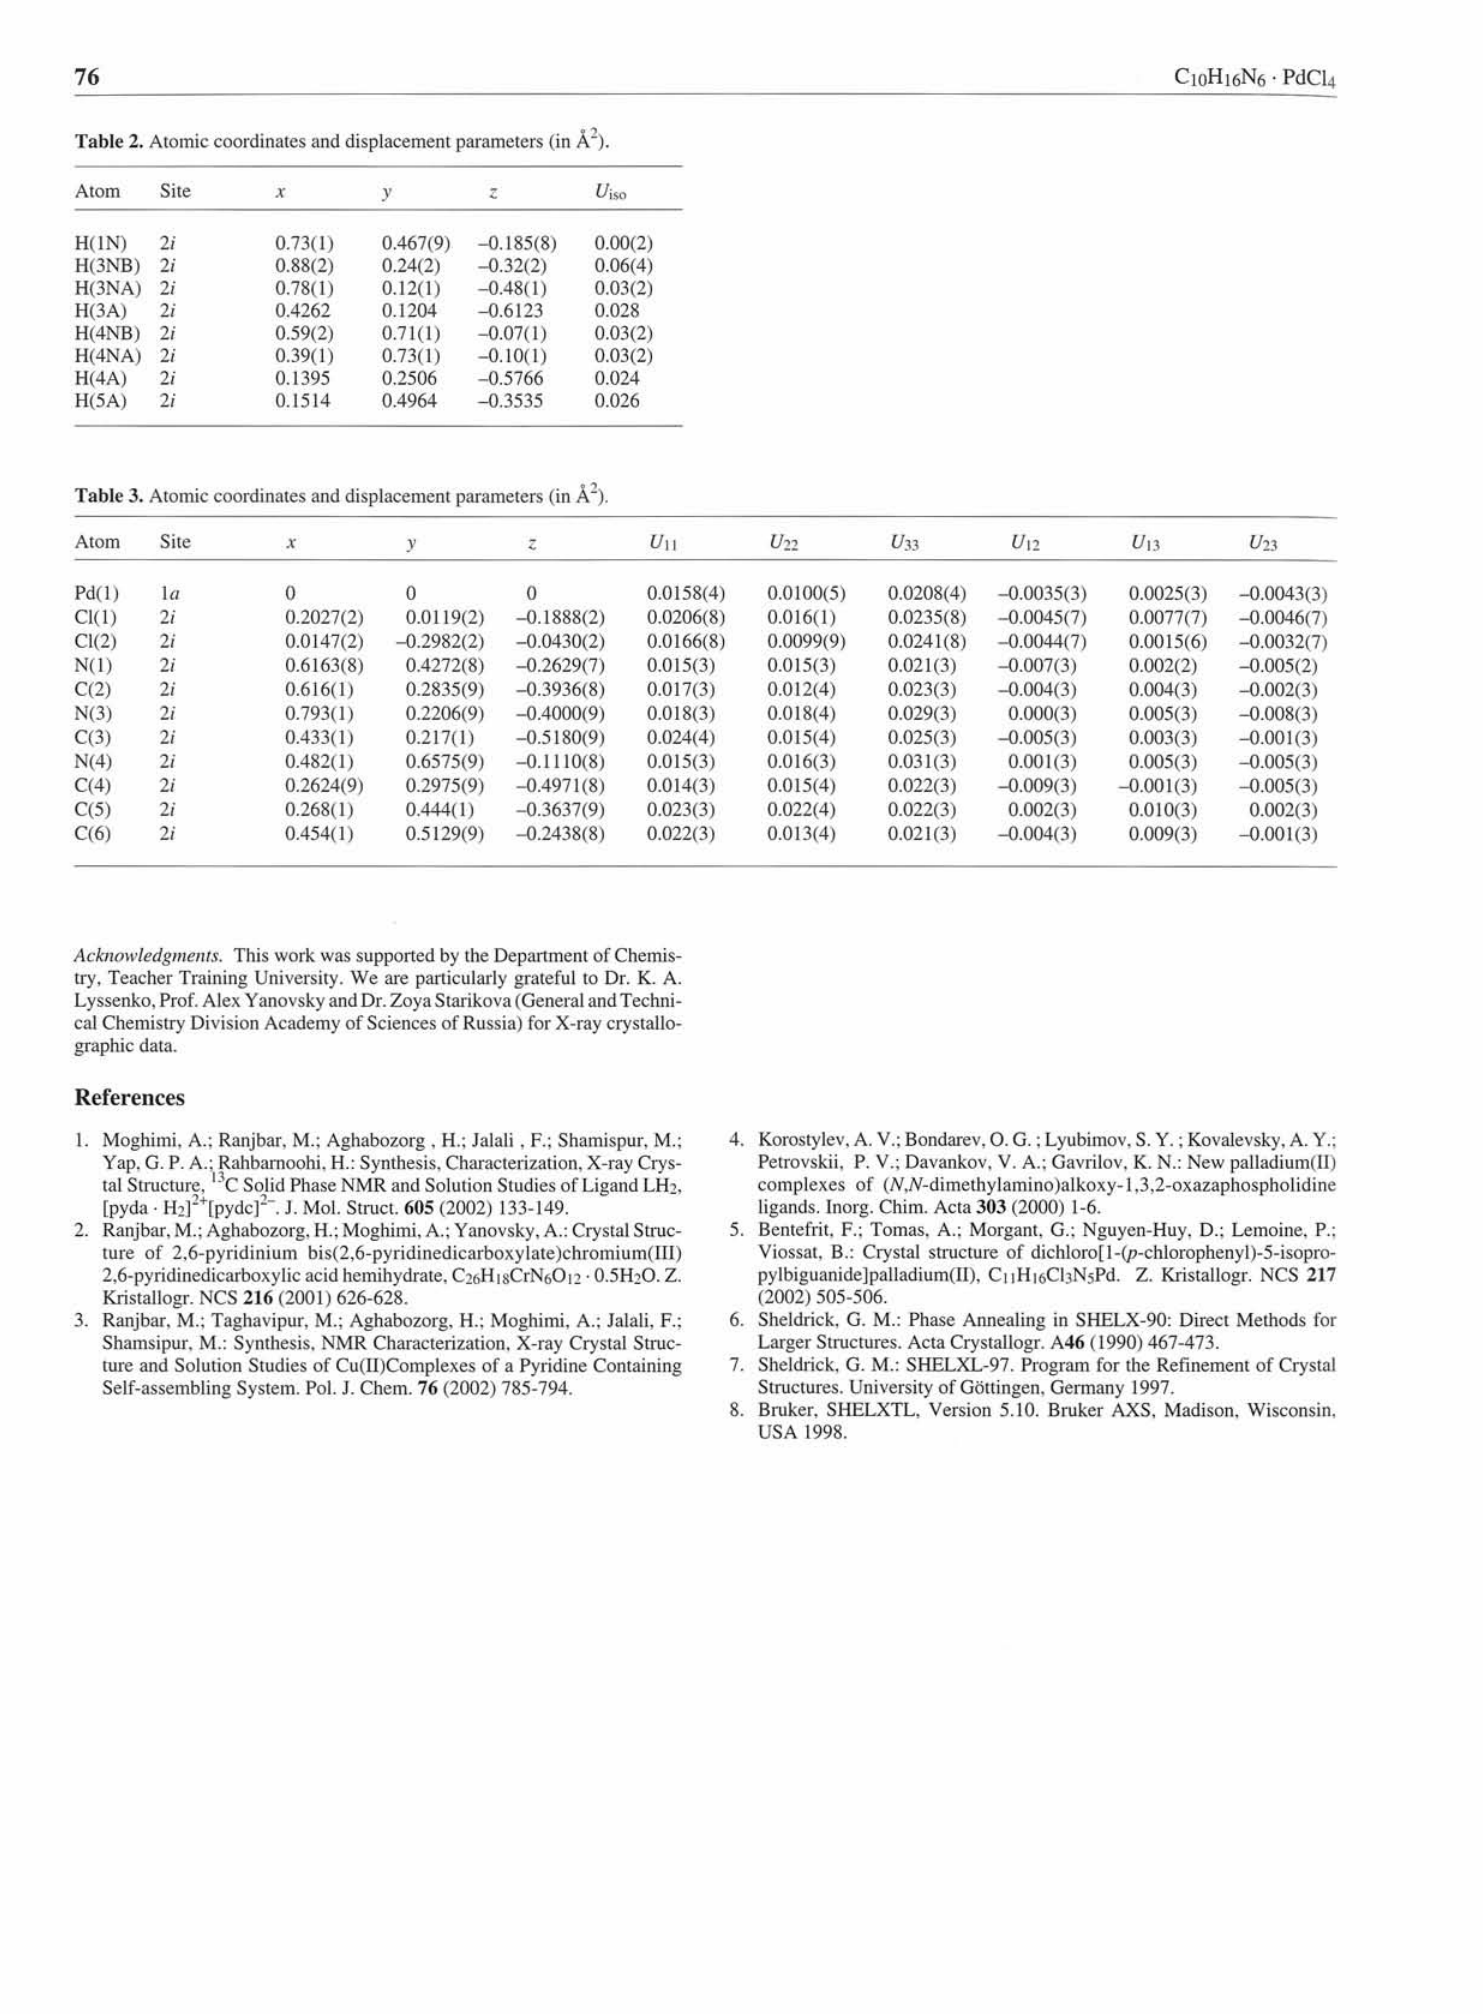
° ? Table 2. Atomic coordinates and displacement parameters (in A").